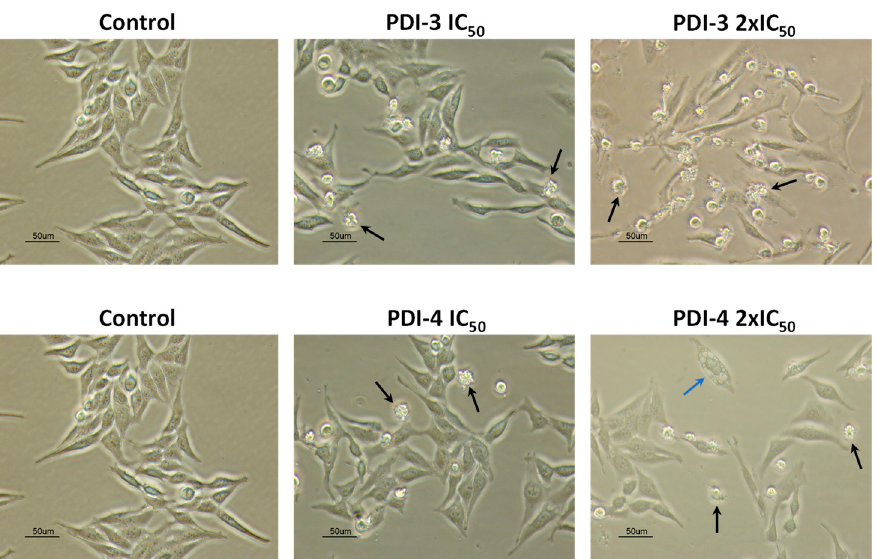
Figure 5. Phase contrast microscopy images of HeLa cells untreated (control) and treated with PDI-3 and PDI-4 at concentrations equal to the IC 50 and 2 × IC 50 µM for 24 h. Black arrows point to apoptotic cells and blue arrow to necrotic cells.